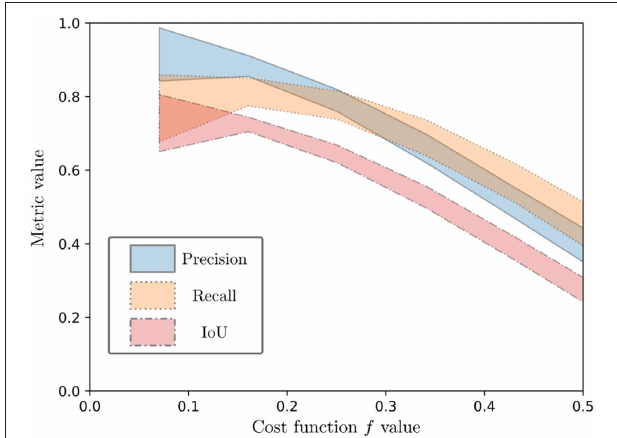
FIGURE 10 | Ninety five percent confidence interval for a 5-order polynomial fitting of the performance metrics (Precision, Recall, and IoU) as a function of the evaluation function.